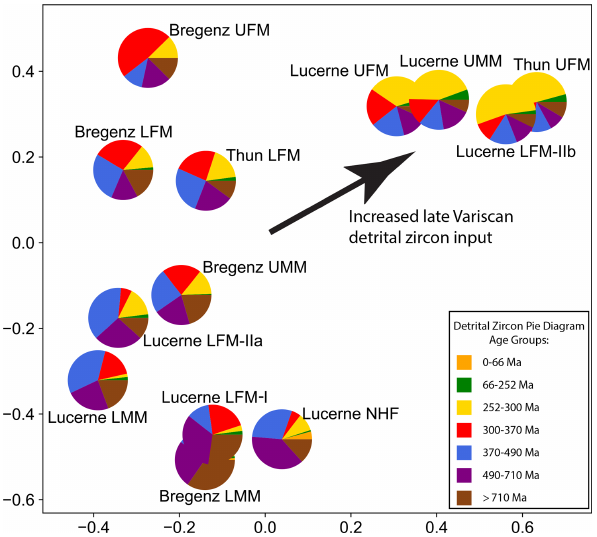
Figure 10. Multidimensional scaling plot (MDS) of detrital zircon U–Pb ages for all units from the Molasse Basin. The MDS plot was produced with the DetritalPy software of Sharman et al. (2018b) and is based on methods outlined by Vermeesch (2018). Pie diagram colors correspond to age groups discussed in Sect.